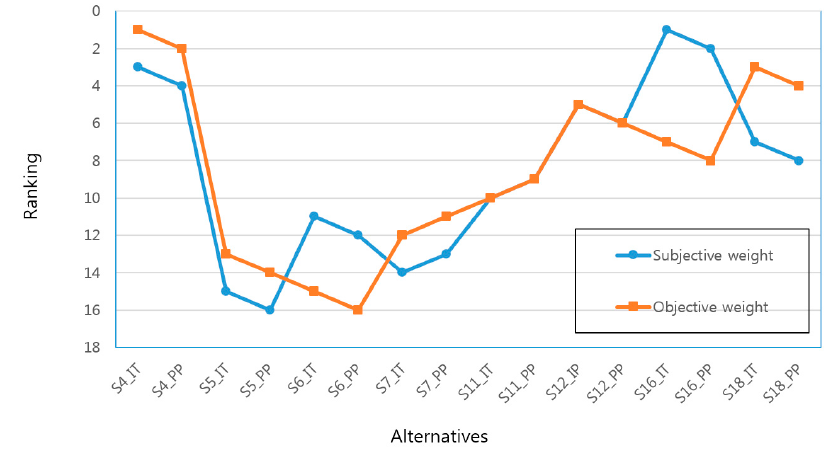
Figure 5. Derived rankings of each alternative.